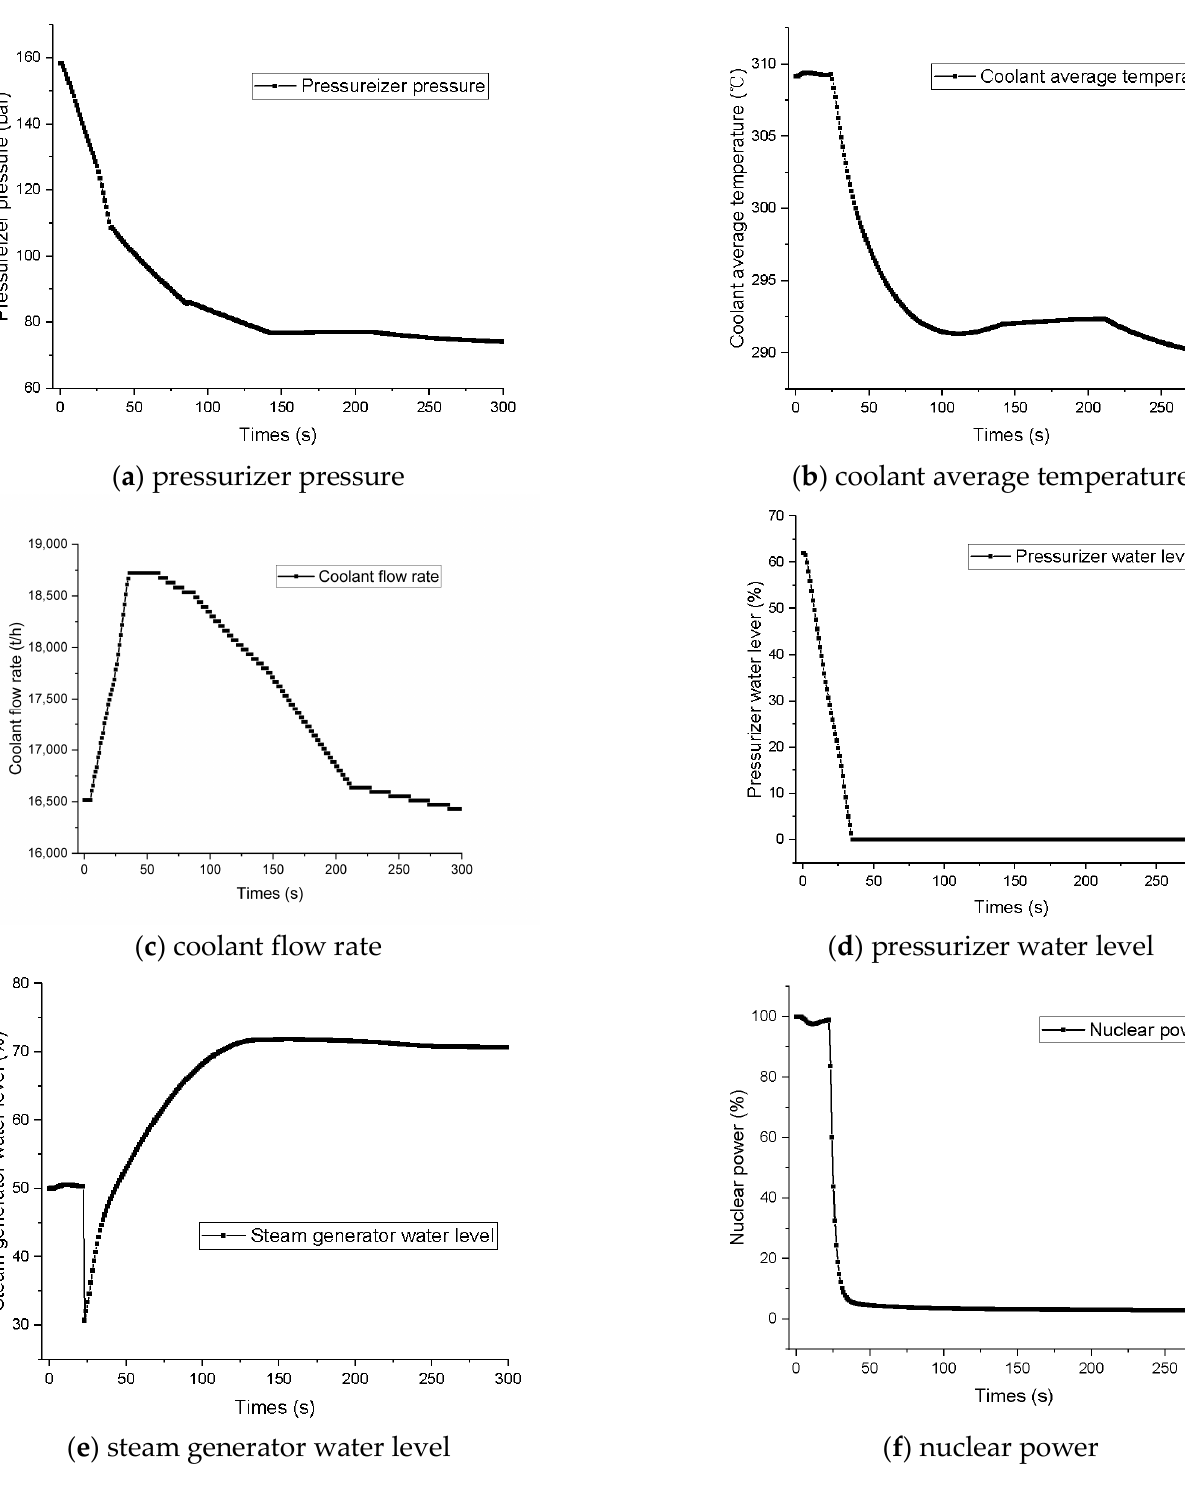
Figure 7. Operating trend of loss of coolant accident.